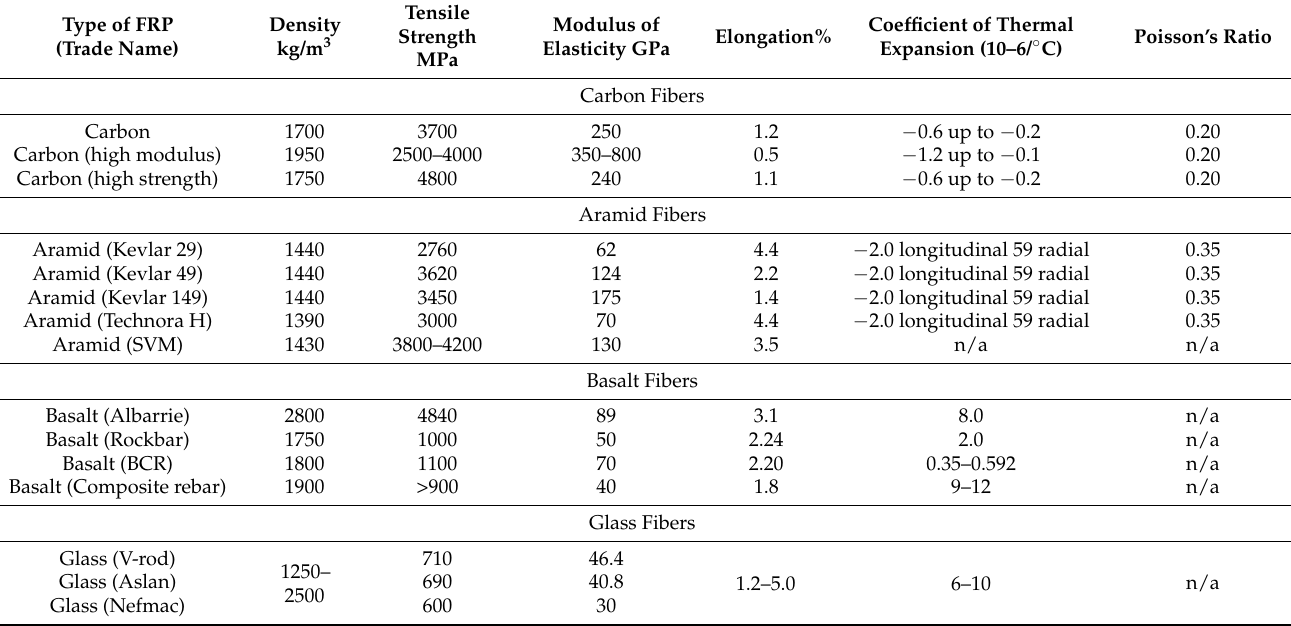
Table 1. Typical FRP mechanical properties [9,44,46].